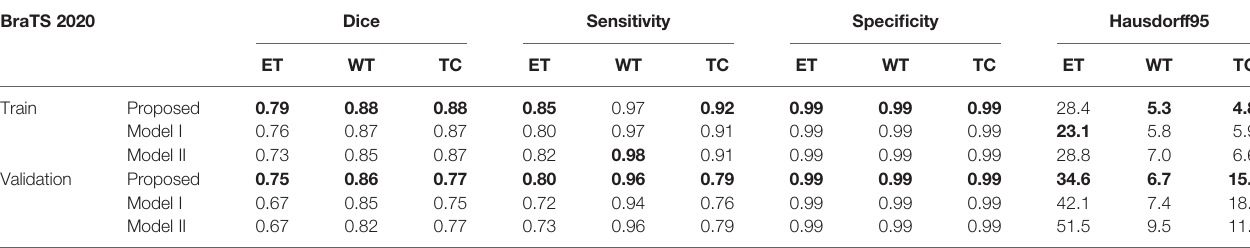
TABLE 5 | Comparison of validation set of teams participating in the BraTS 2020 challenge. TABLE 6 | Accuracy comparison with other comparative experiments. Train Proposed Proposed Bold values indicate the best performed method.